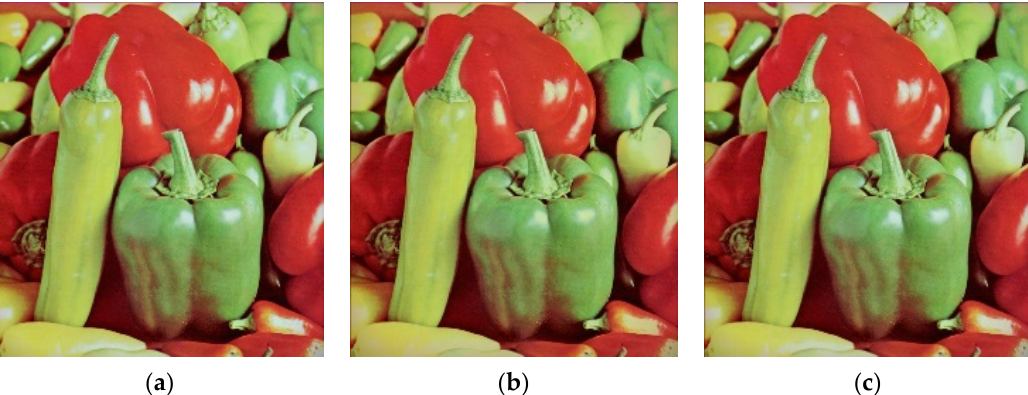
Figure 12. Red, green, blue (RGB) liquid crystal displays (LED) dimming simulation result. ( a ) Original image; ( b ) Conventional RGB dimming; ( c ) Proposed RGB